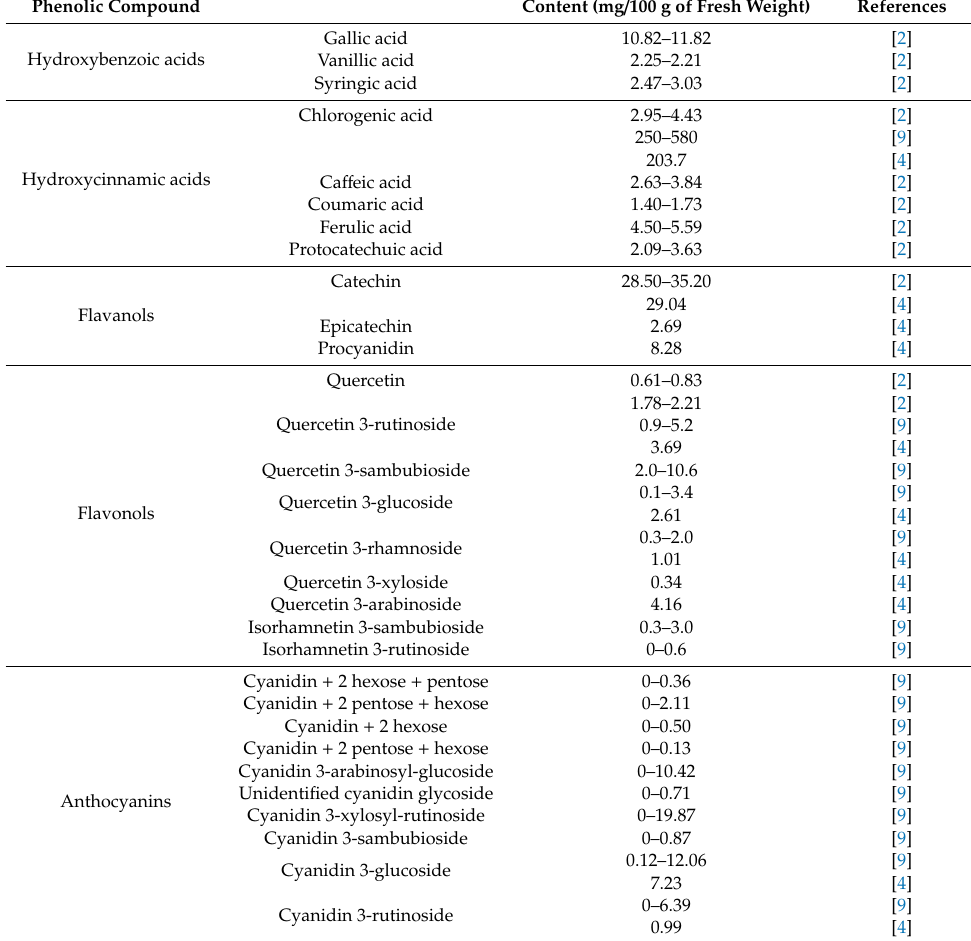
Table 3. Phenolic compounds identified in Viburnum opulus fruits. Phenolic